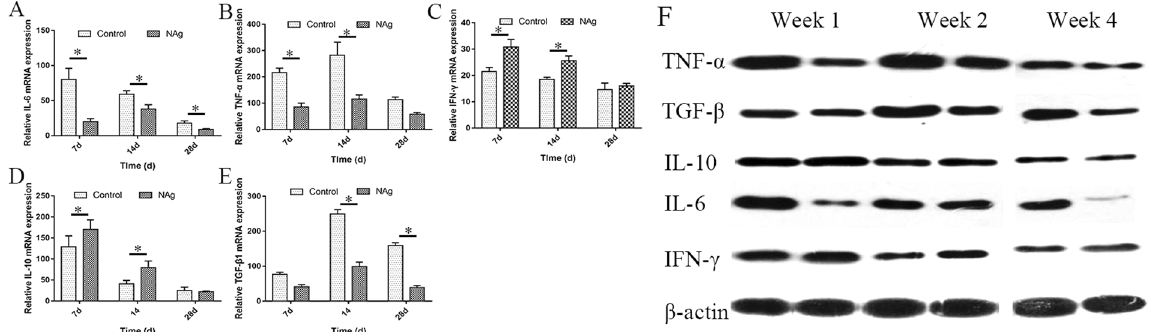
Figure 8. NAg-CCS downregulated inflammatory mediators and upregulated macrophage activation associated factors in full-thickness wounds at day 7, 14 and 28 post transplantation. Real-time quantitative analysis of TNF- α ( A ), IL-10 ( B ), IL-6 ( C ), IFN- γ ( D ) and TGF- β 1 ( E ) mRNA expression. ( F ) Western blotting analysis of TNF- α , CD68, IL-10, IL-6 and IFN- γ of the NAg-CCS (left) and CCS (right) implanted at day 7, 14, 28 post transplantation, respectively. The gels/blots were cropped and full-length gels and blots were included in the Supplementary Information